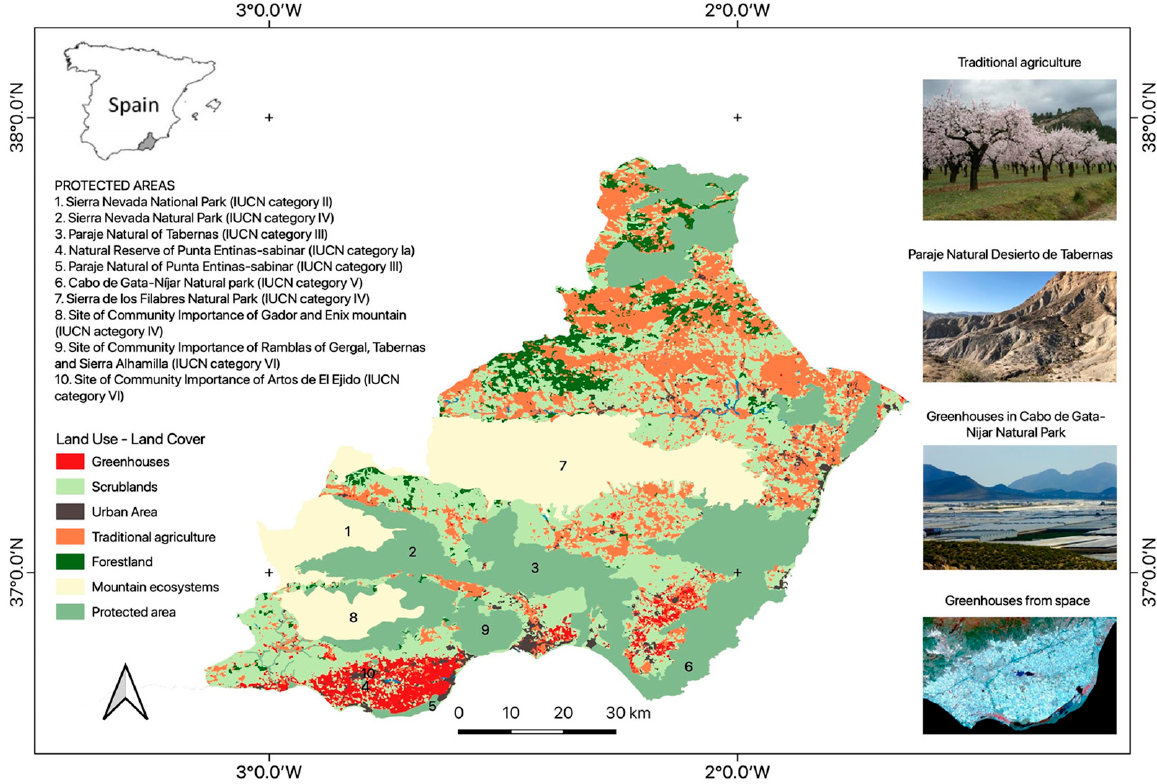
Figure 1. The geographic location of greenhouse horticulture in Almería, SE Spain.